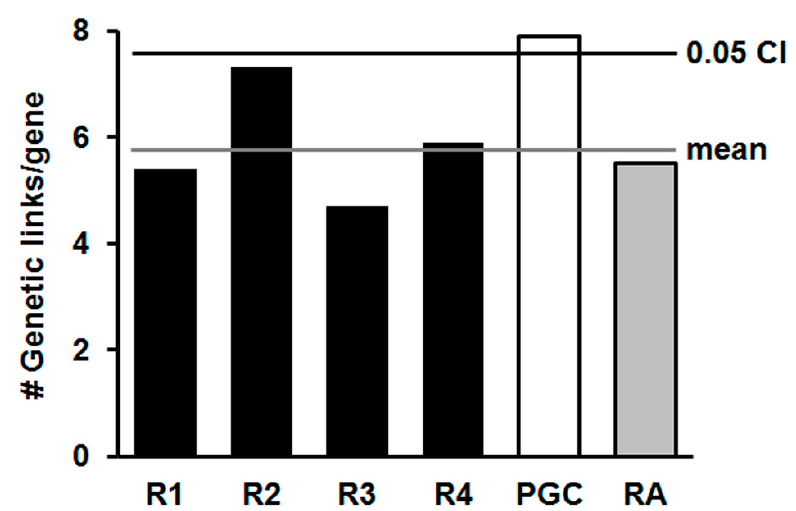
Figure 4. Genetic interactions among PGC risk genes. (A) The degree of genetic interaction among genes from 4 random gene lists (R1-R4) was analyzed with GeneMANIA and compared with the degree of interaction among risk-gene candidates from the PGC dataset and a rheumatoid arthritis (RA) dataset. The data are plotted as the number of genetic links per gene in the input lists that show interactions in the Lin et al. [39] dataset. The average of the 4 random lists is indicated with a gray line and the CI ( p < 0.05) with a black line.